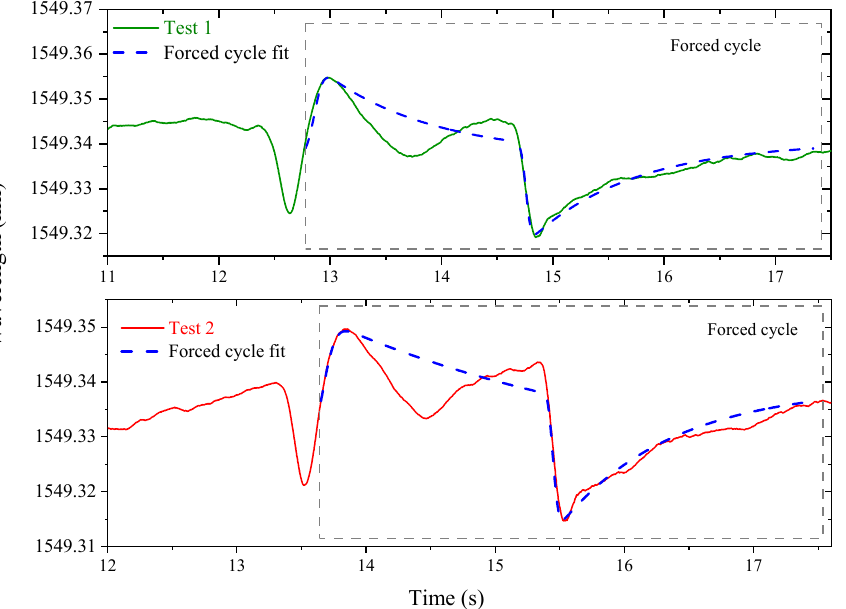
Figure 7. Results obtained using the FPI-based spirometer, concerning the area of the forced breathing cycle.